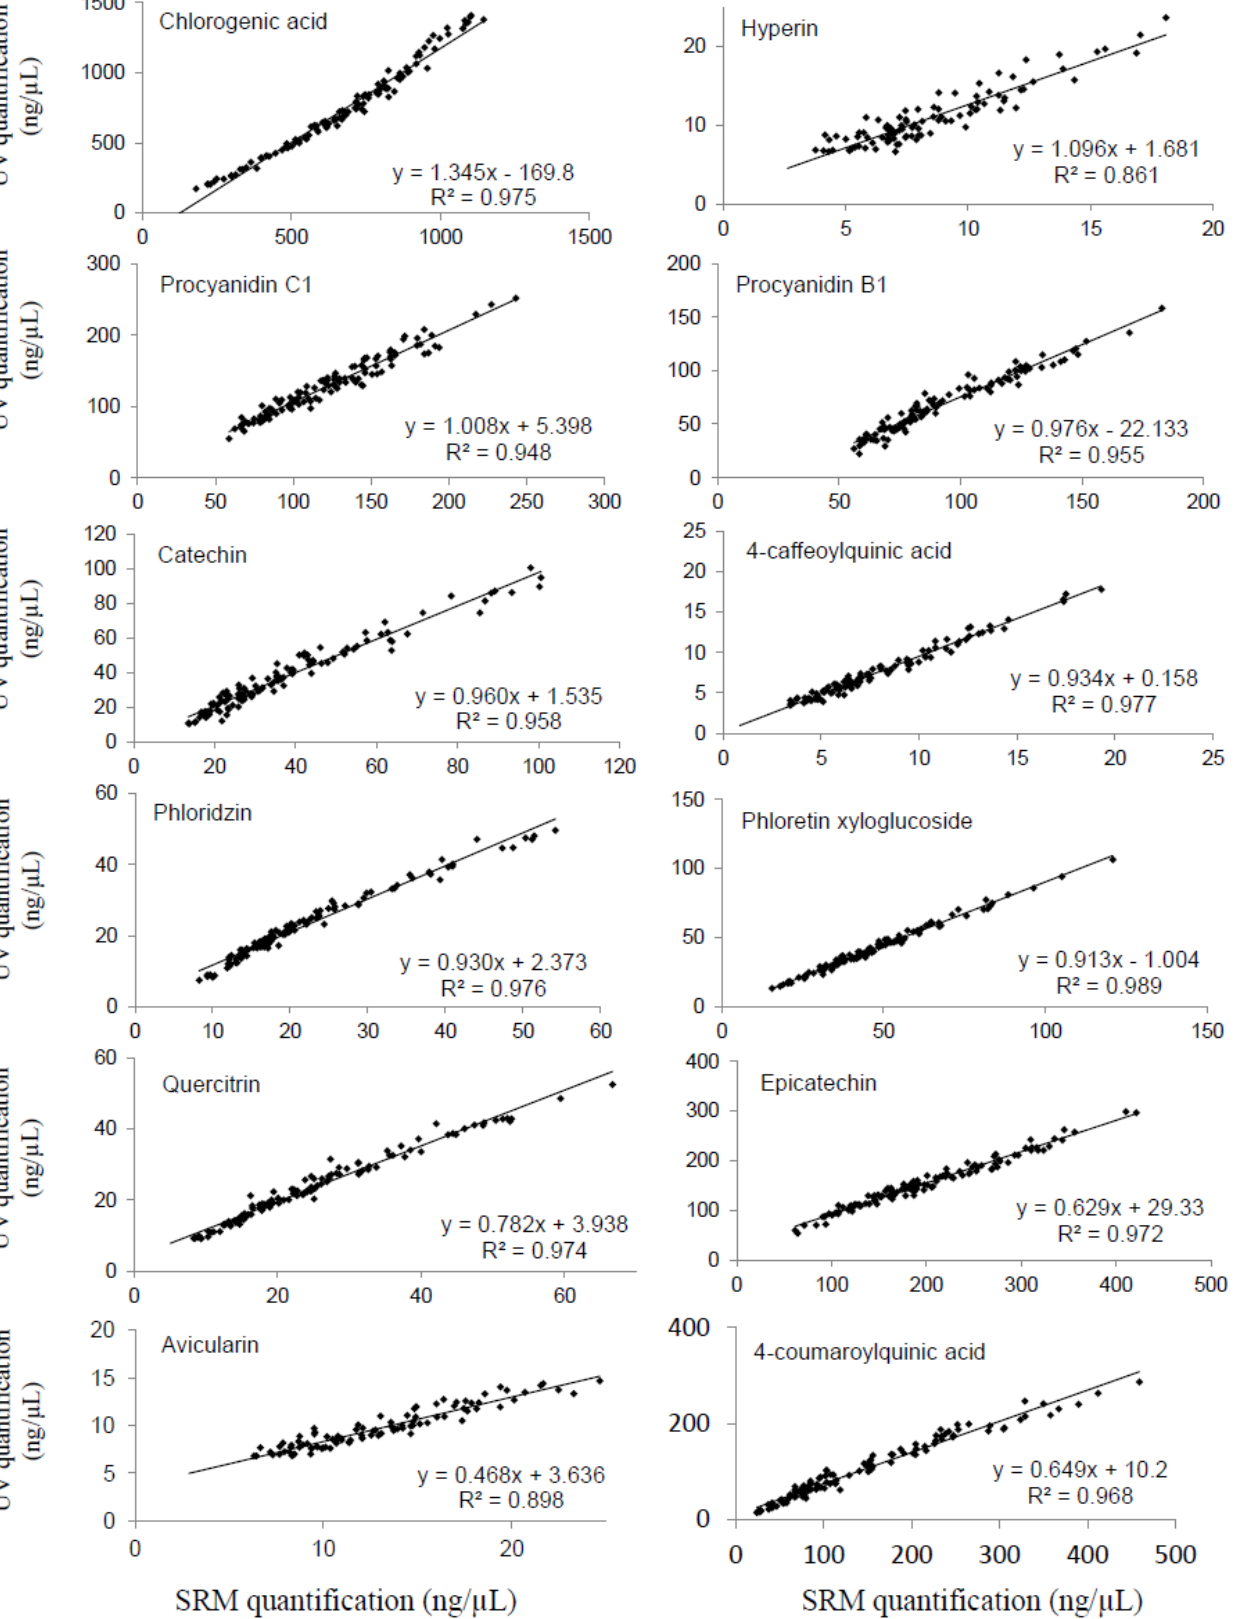
Figure 3. Comparison of the quantifications of 120 apple juices (n = 3, P value < 0.0001) with the UV- PDA detector (X-axis) and the ESI-triple quadrupole mass analyzer